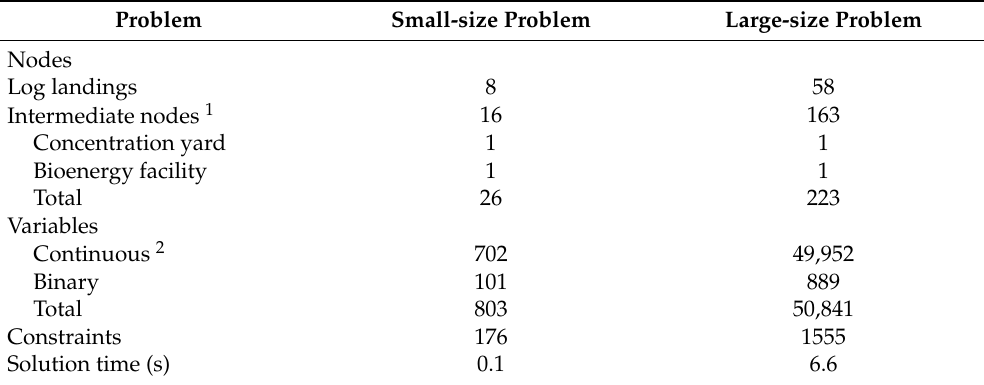
Table 6. Problem size and solution time of the two model applications presented in this